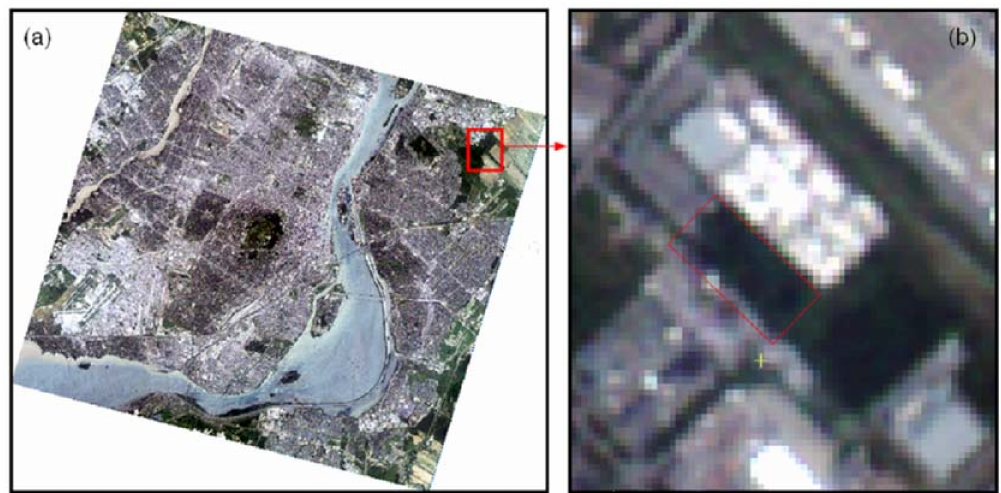
Figure 16. Example of an agricultural field bordered by glossy surfaces in the red band on the Formosat-2 image dated 5 June 2005. Location coordinates: 45 ◦ 33 (cid:48) 30”N; 73 ◦ 25 (cid:48) 30”W; ( a ) global location; ( b ) zoom on the field.